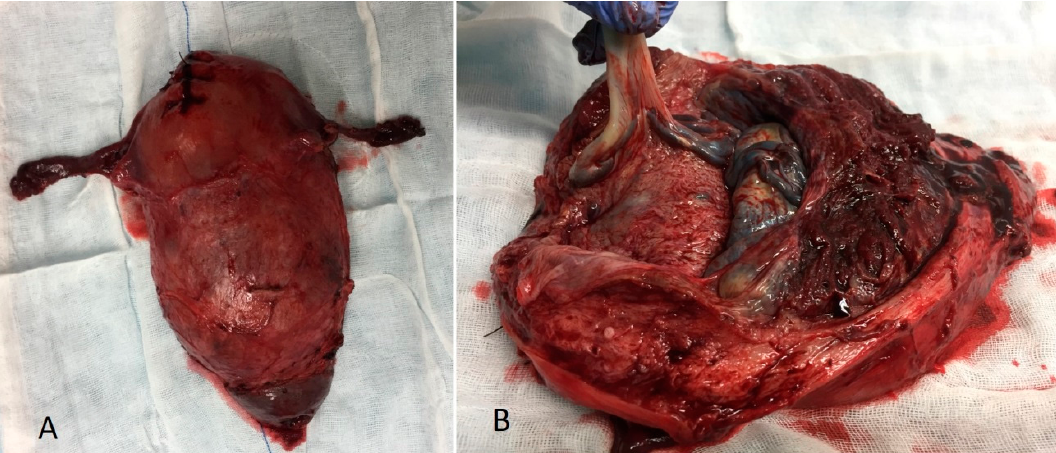
Figure 4. ( A ) Total hysterectomy surgical specimen. ( B ) Opened surgical specimen showing the extension of the placental accretism. Abnormal invasive placenta lays on the whole inferior side of the uterus.